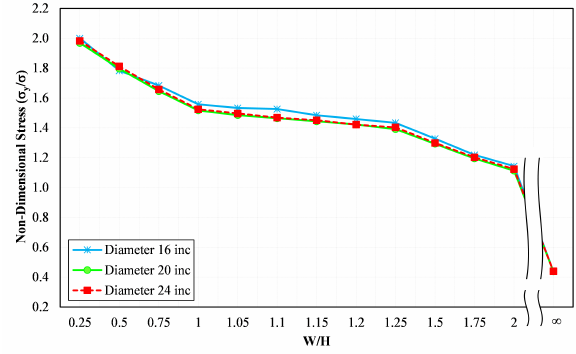
Figure 6: Relations between σ y / σ with W / H of expansion loop at 400 o F